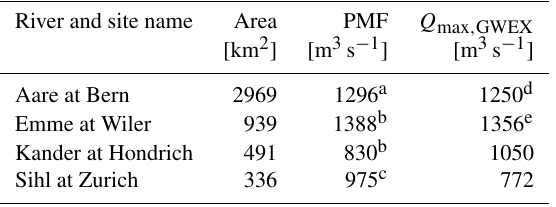
Table 2. Probable maximum flood (PMF) estimates reported in the literature that apply to the perimeter covered in the present study and corresponding maximum peak flows from CS based on GWEX ( Q max , GWEX